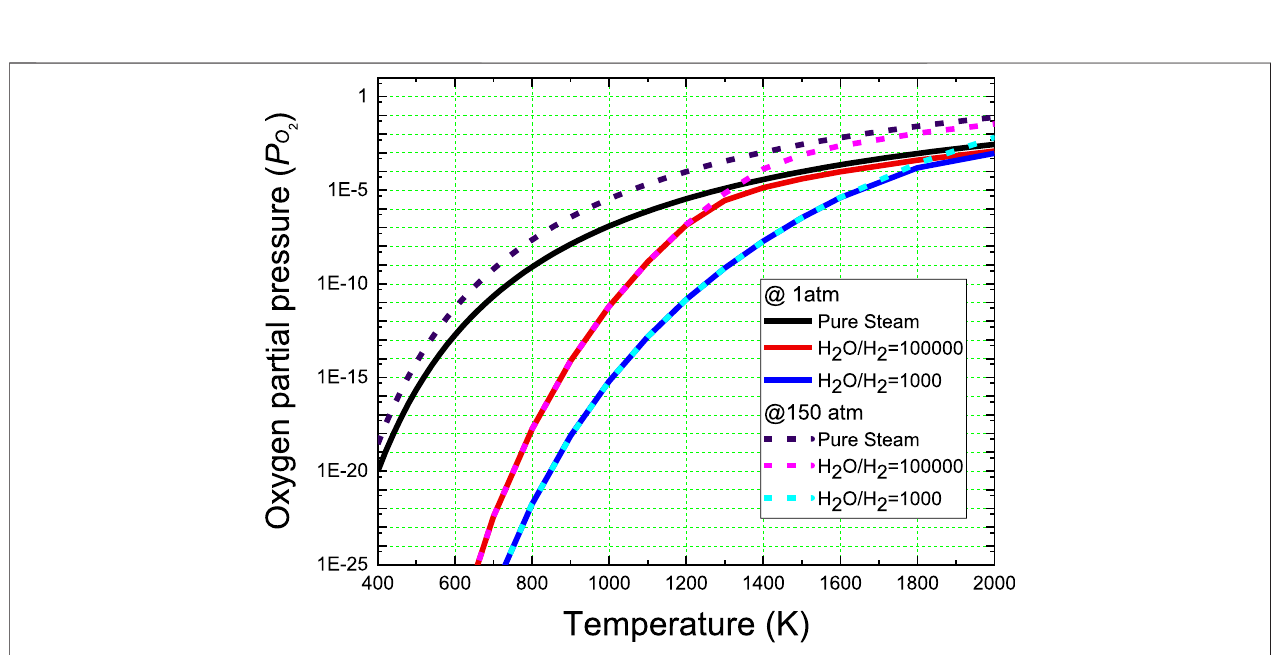
FIGURE 2 | Effects of H 2 mixing and pressure on the equilibrium oxygen partial pressures of steam calculated by Olander ’ s equation (Olander, 1986).